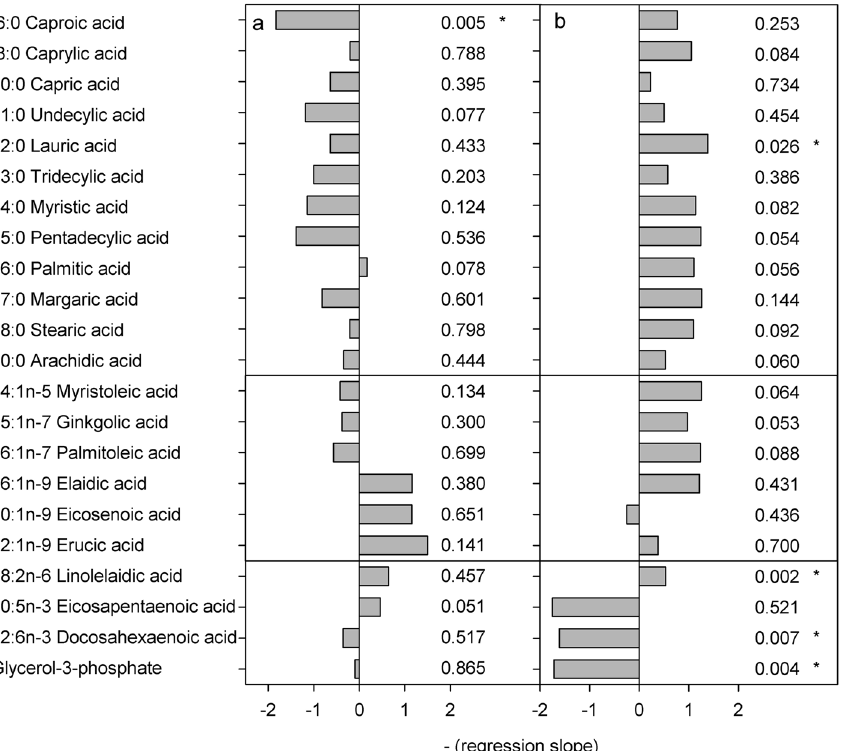
Figure 6. Results of linear regressions of transformed fatty acid concentrations in C. glacialis copepodites as a function of pH (range 8.0–7.0 pH T ). ( a ) Copepodite stage CIV, ( b ) copepodite stage CV. The horizontal grey bars show negative regression slopes to indicate the direction of change with decreasing pH and the numbers show the p-values of the slopes, asterisks mark significant slopes. Upper panel shows saturated fatty acids, middle panel shows monounsaturated fatty acids and lower panel shows polyunsaturated fatty